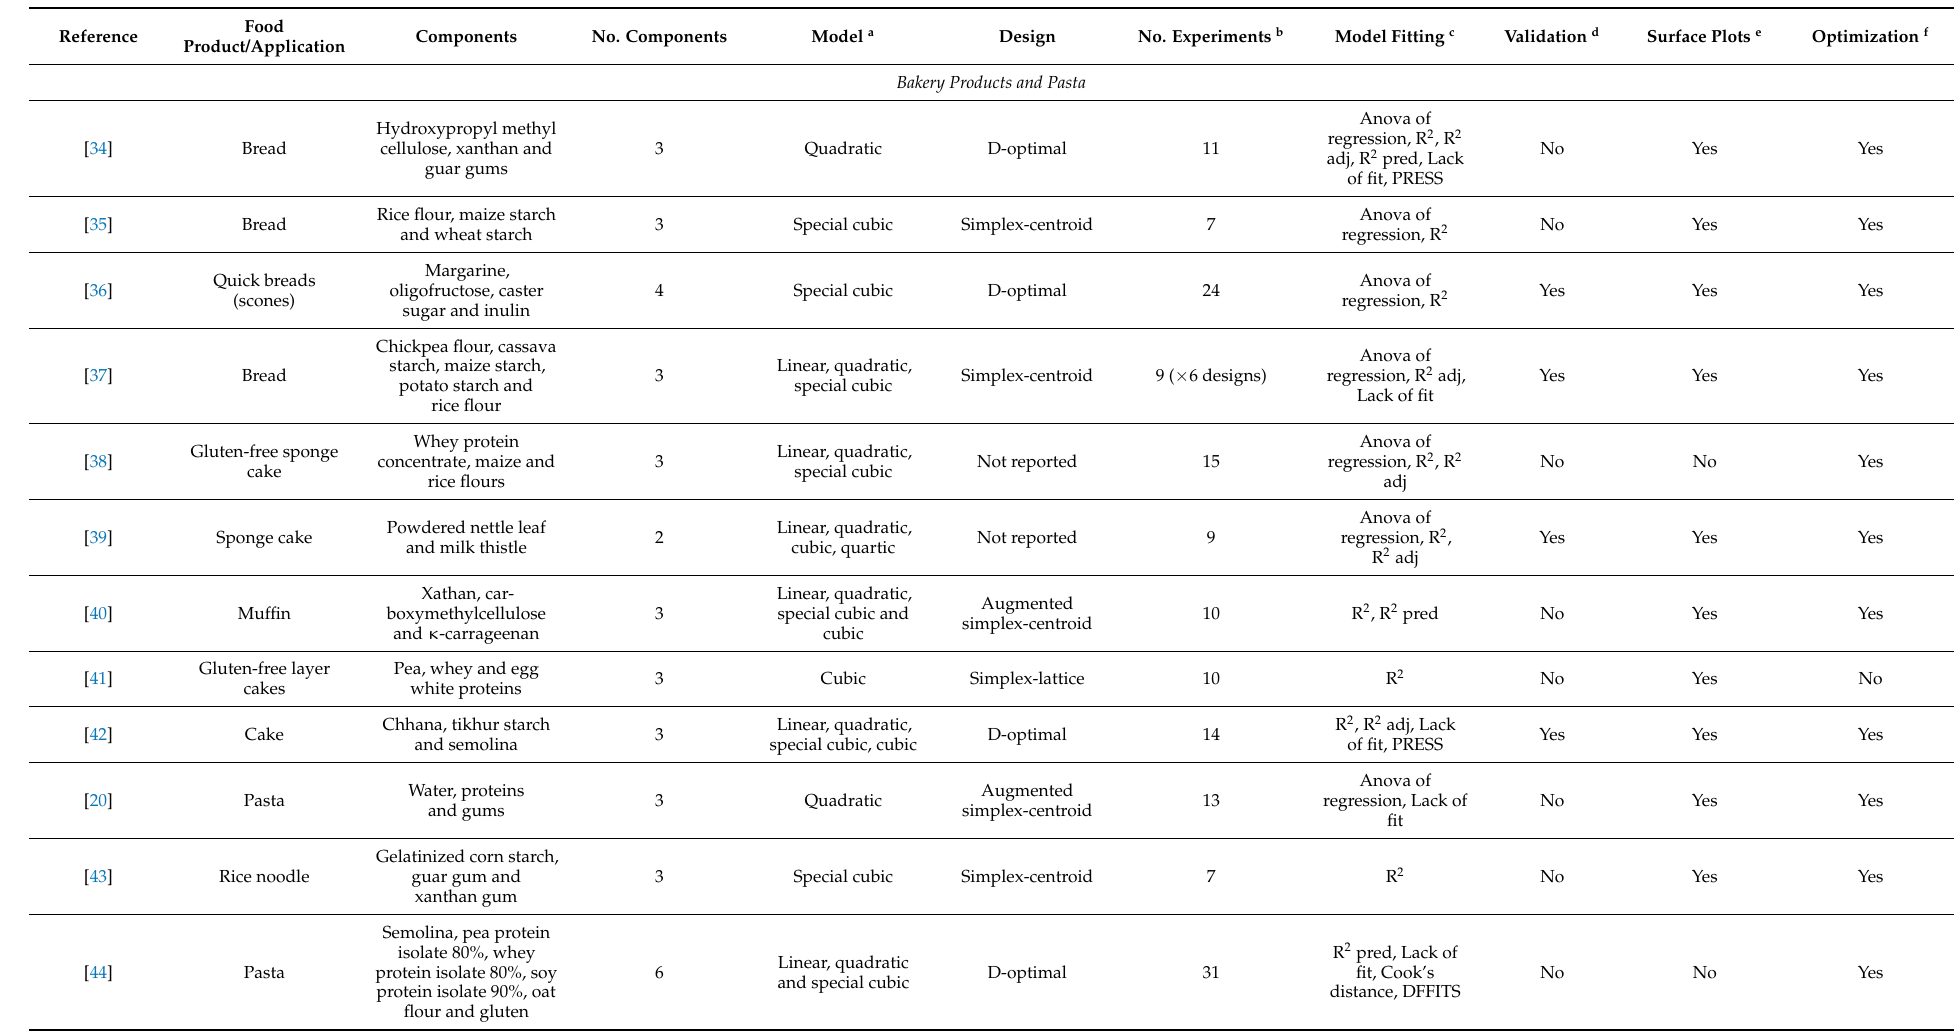
Table 4. Summary of the main features of the mixture designs applied together with the area of